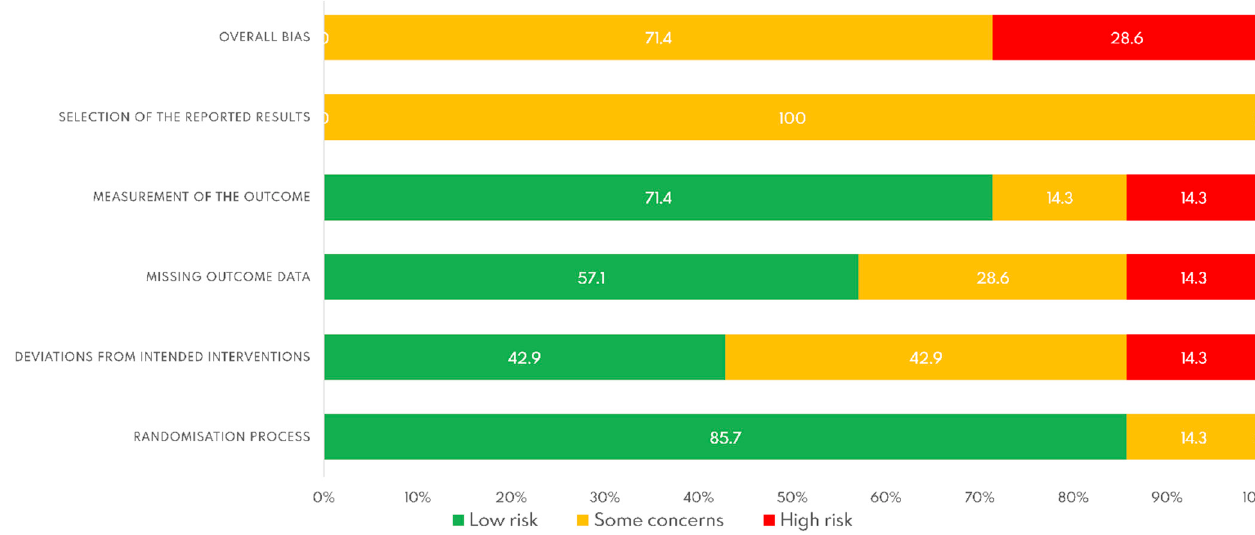
Figure 3. Global risk of bias.